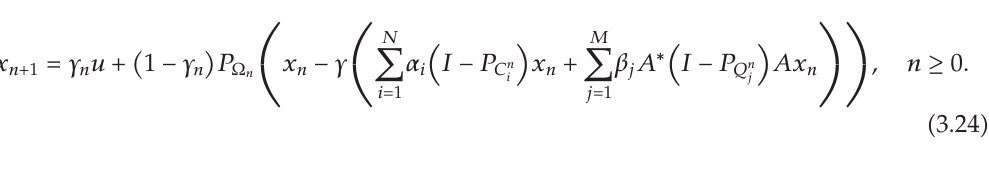
Algorithm 3.22. Given an initial guess x 0 ∈ H 1 , let { x n } be generated by the perturbed iterative